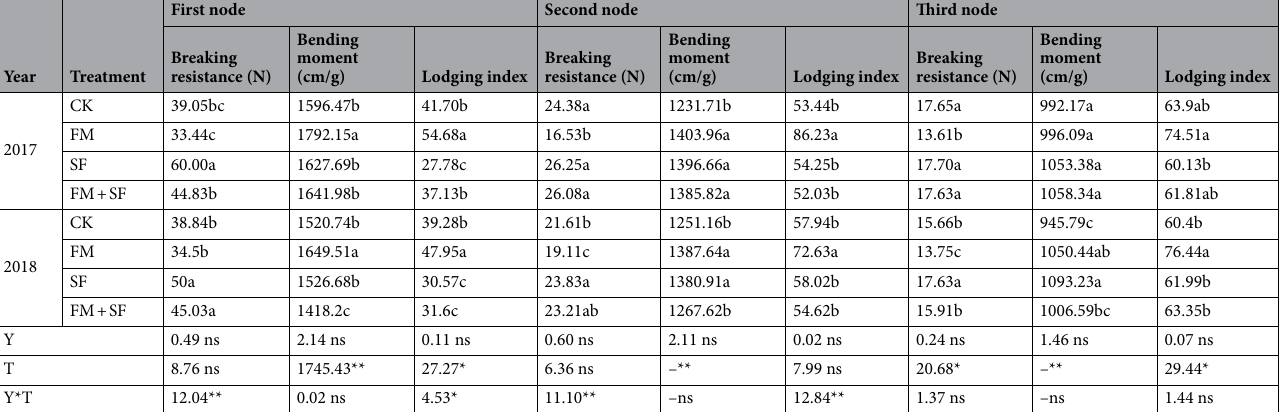
Table 6. Effect of bast fiber film and nano-silicon fertilizer treatments on lodging resistance in rice. Different letters indicate significant difference at 5% level. Summary of ANOVA results: not significant (ns), significant